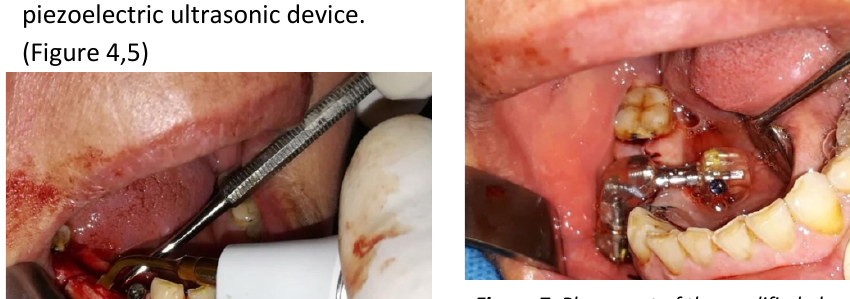
Figure 7. Placement of the modified alveolar distractor